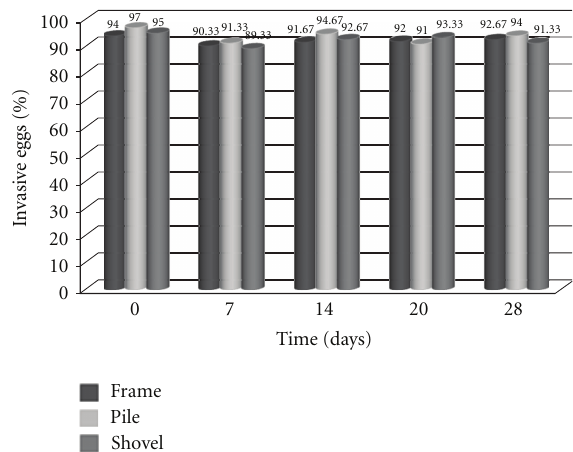
Figure 12: The course of inactivation of Ascaris suum eggs in winter cycle